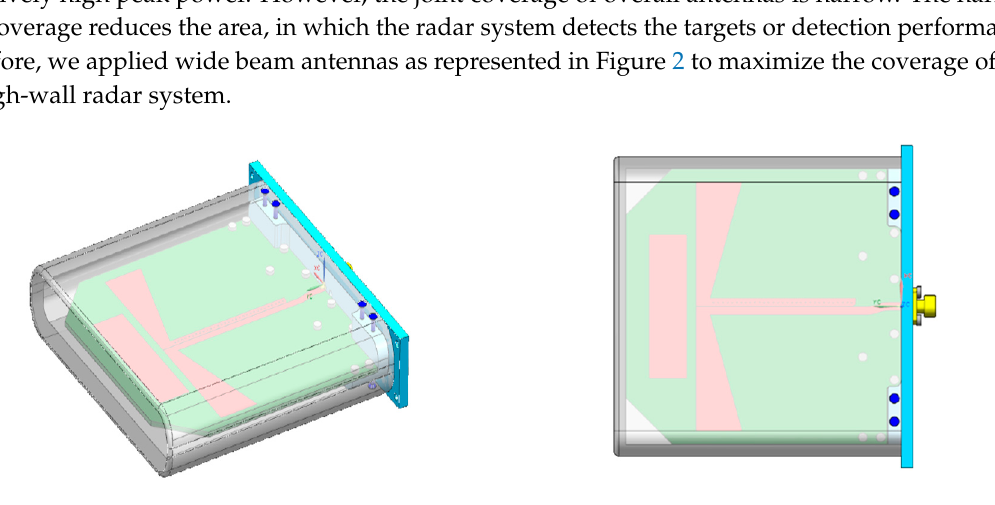
Figure 2. Half bow-tie quasi-Yagi